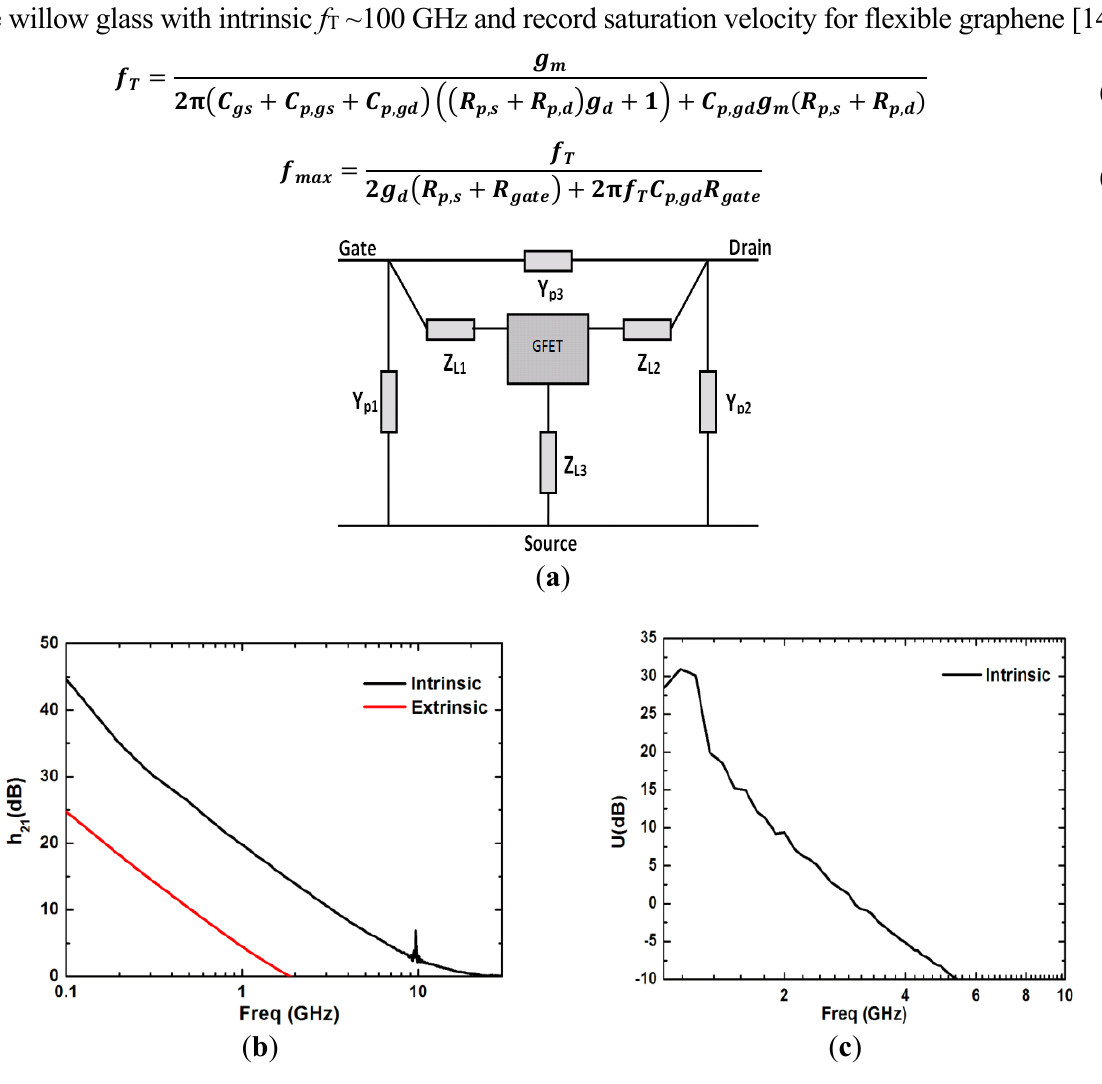
Figure 4. ( a ) RF model of GFET under test, where Y p1 , Y p2 and Y p3 are parallel parasitics and Z L1 , Z L2 and Z L3 are series parasitics (They represent GFET contact pads and interconnects). ( b ) Current Gain (h 21 ) vs. Frequency. The intrinsic f T ~18 GHz; ( c ) Power gain (U) in dB vs. Frequency. f max ~3 GHz. These devices are measured at the following voltage conditions ( V drain ~0.4 V, V gate ~0.2